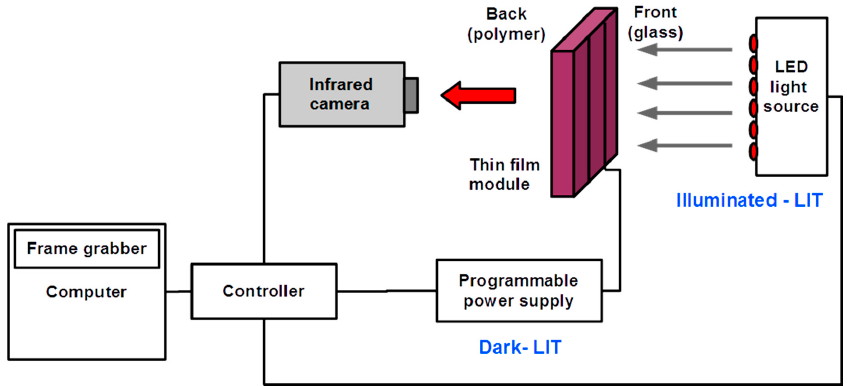
Figure 4. Schematic of LIT measurement system under dark and illuminated conditions.